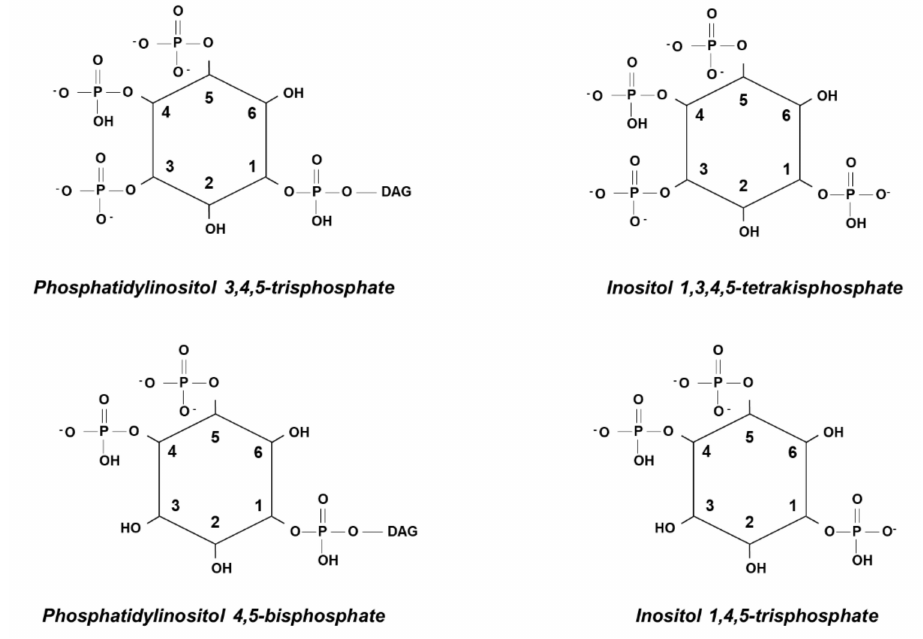
Figure 4. Schematic representation of phosphoinositides and their corresponding inositol